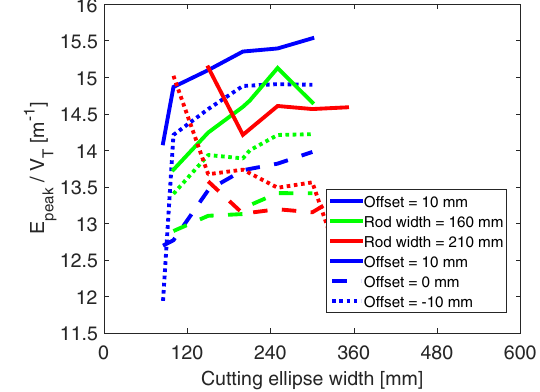
=V FIG. 17. E T vs cutting ellipse width for different rod peak widths and offsets.